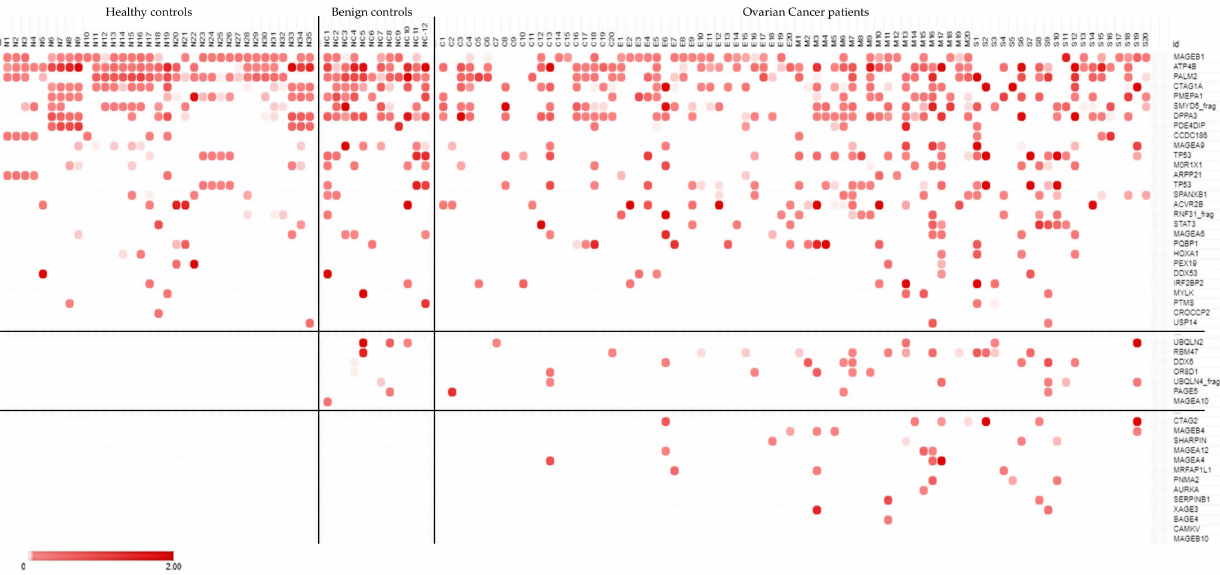
Figure 2. Antigen reactivities identified with ovarian cancer cohort 2 using the custom protein array. Healthy controls ( n = 35), benign controls ( n = 12) and ovarian cancer patients ( n = 80) were screened using the CDI custom protein array. Data not shown for PLEKHA8 and PRM2 due to abundant uniform reactivity observed across all healthy, all benign and almost all cancer samples ( n = 78/80, n = 79/80 respectively). Data are shown as Z-scores, with scale bar set from 0 (white) to 2 (bright red), and all values with a Z-score < 0 are in white. Ovarian cancer subtypes are classified as clear cell (C1-20), endometrioid (E1-20), mucinous (M1-20) and serous